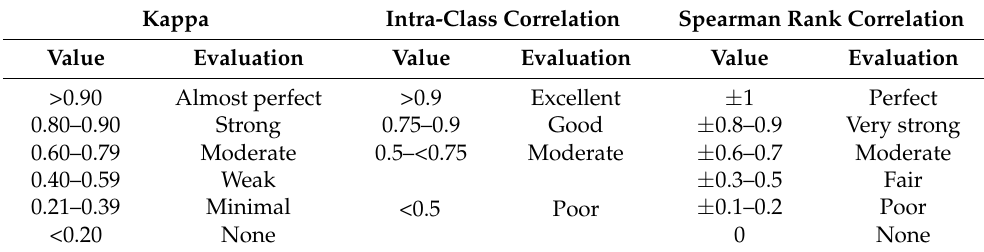
Table 1. Evaluation guideline. Kappa Intra-Class Correlation Spearman Rank